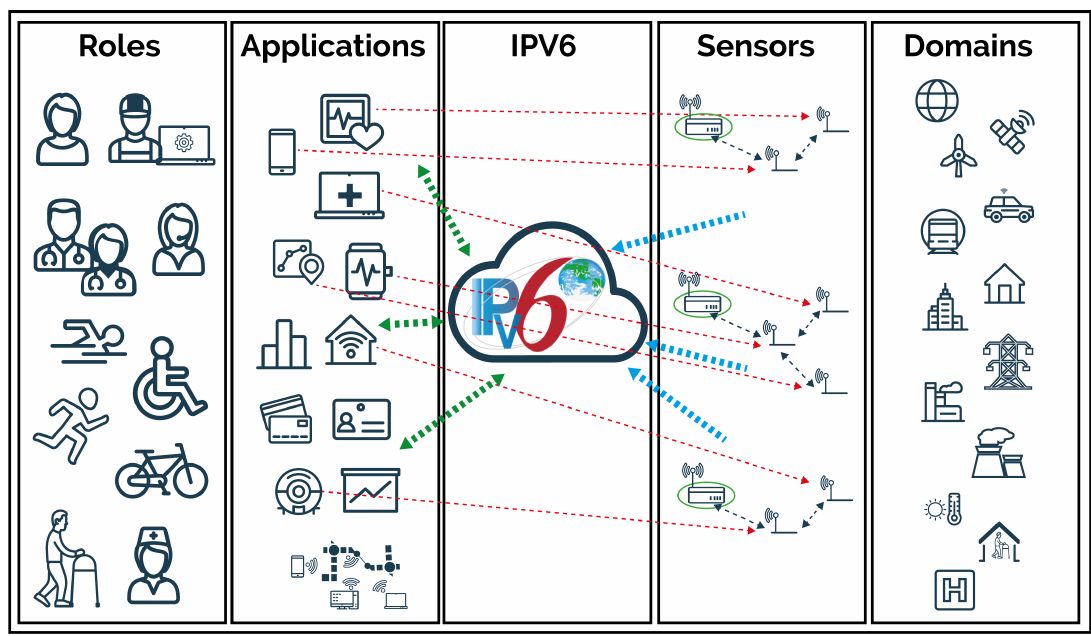
Figure 1. Scenario schema, where several stakeholders playing different roles access E2E IoT applications on different IoT domains through CDSs acting both as simple publishers (thick arrows) and as tiny E2E servers (thin